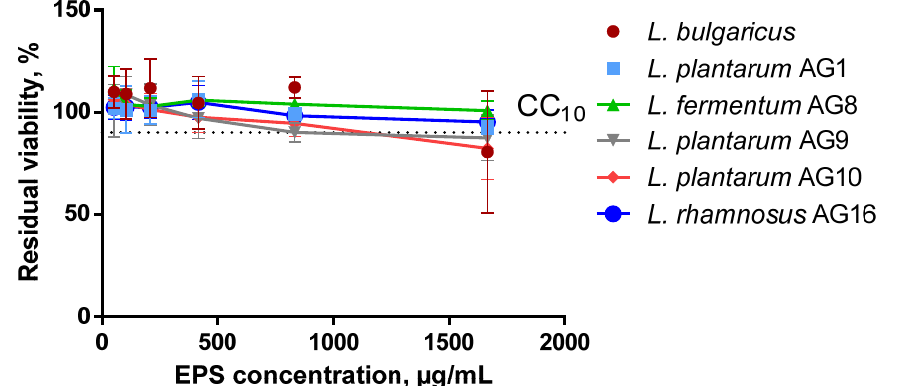
Figure 5. Cytotoxicity of EPS isolated from skim milk fermented by different strains of LAB (MTT ‐ test, human fibroblasts). human